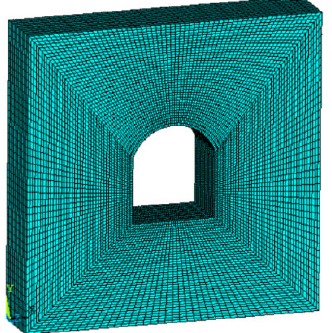
Figure 2. Model meshing.